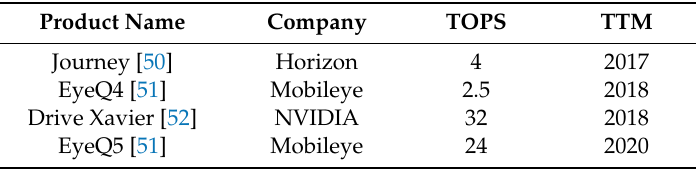
Table 5. Main product performance of self-driving